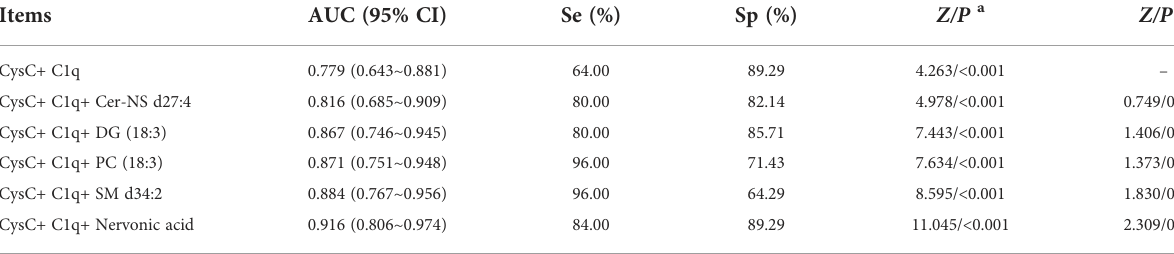
TABLE 5 Combined diagnostic performance of CysC, C1q and new-found metabolites.